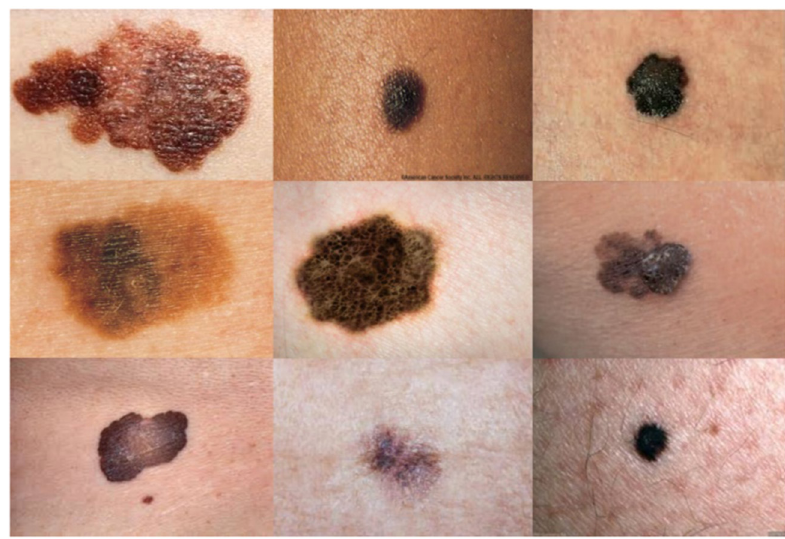
Figure 5: Some examples of the used dataset from